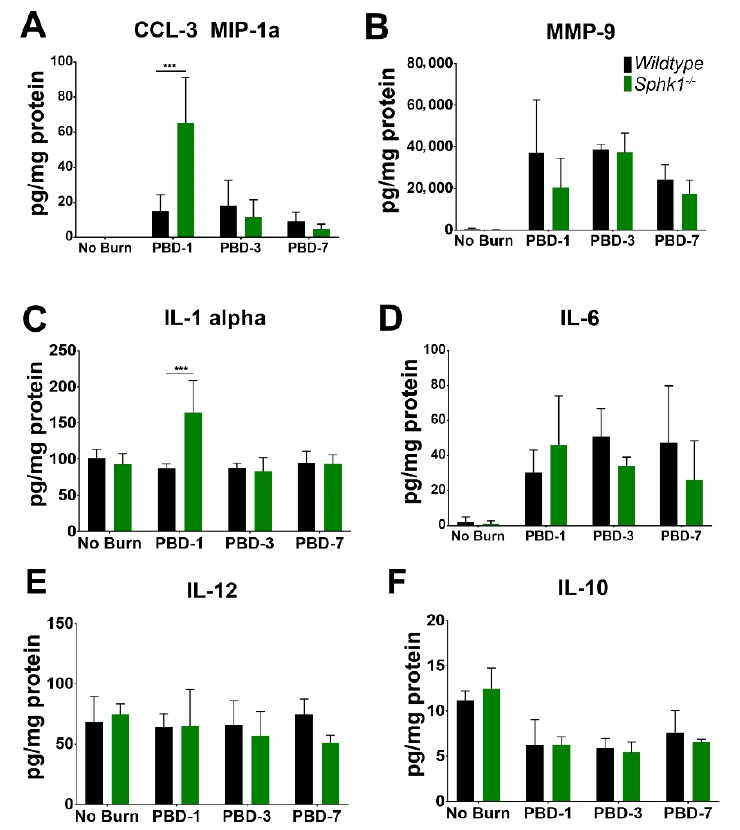
Figure 6. Inflammatory markers are altered in the cornea following alkali burn. WT and Sphk1 -/- mice corneas ( n = 3) were harvested 1, 3, and 7 days post alkali burn together with unburned controls, and the levels of inflammatory cytokines CCl-3 ( A ), MMP-9 ( B ) IL-1 α ( C ), IL-6 ( D ), IL-12 ( E ) and IL-10 ( F ) were measured by Luminex assay. (Values are mean ± SD, *** p ≤ 0.05).